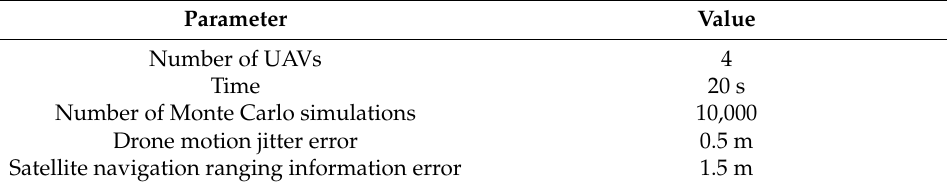
Table 1. Parameter settings.